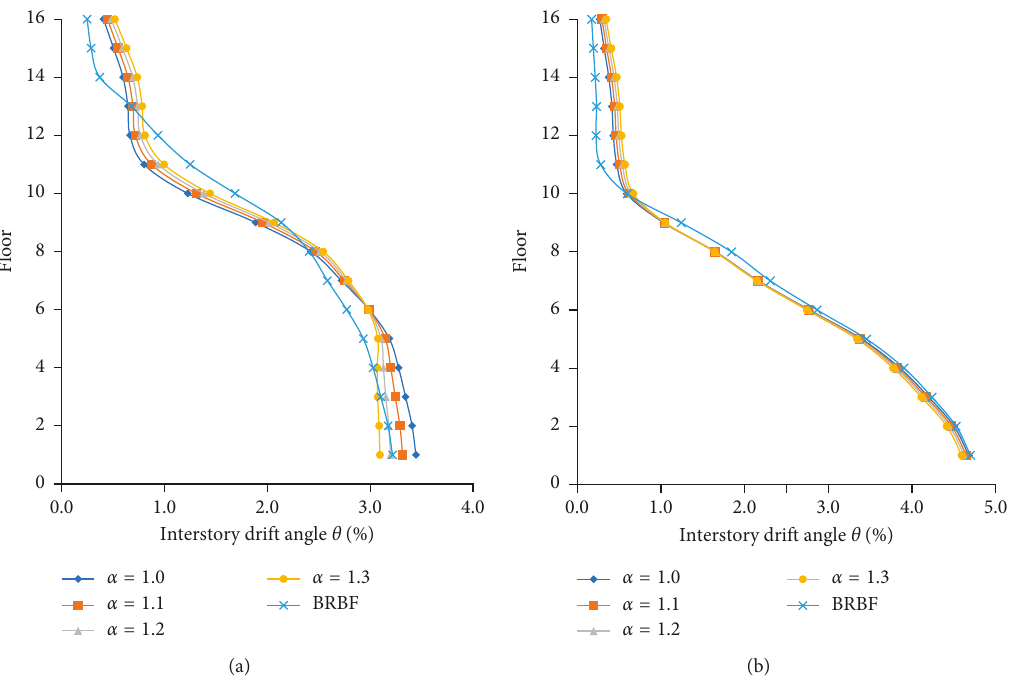
Figure 23: The effects of α on the interstory drifts of 16-story SC-TOBFs: (a) LD-1 and (b) LD-2.